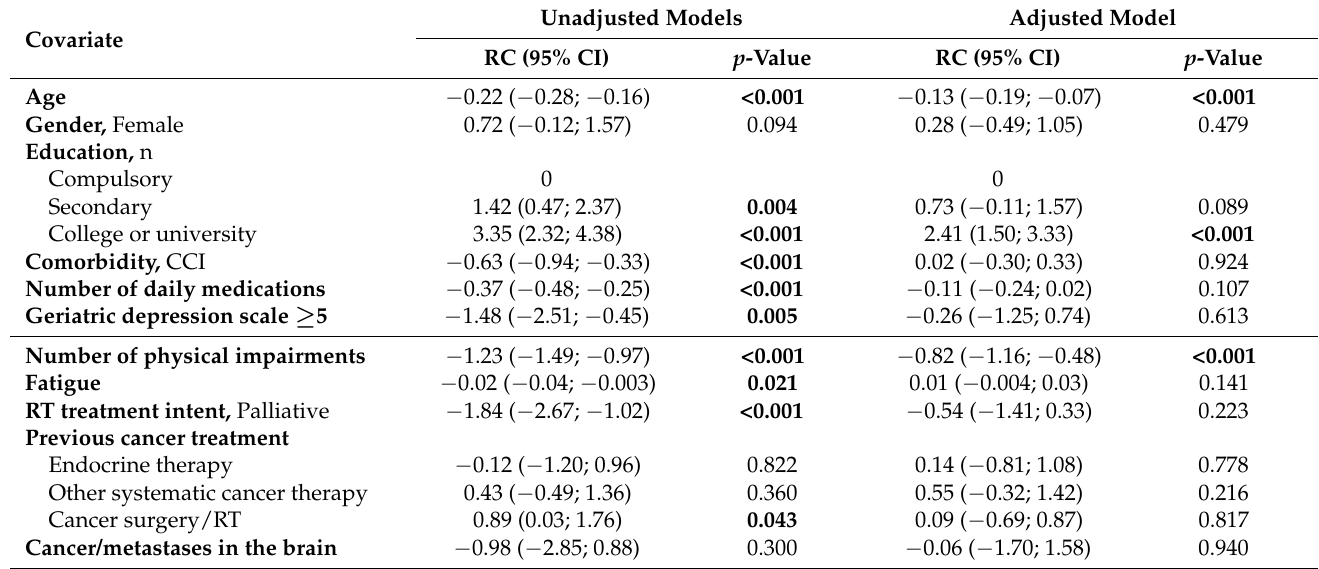
Table 4. Results of linear regression analyses investigating factors associated with baseline MoCA scores, ( n =